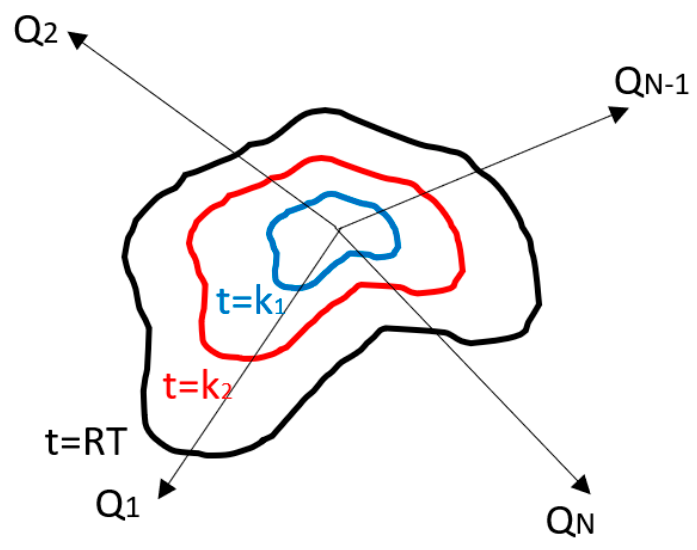
Figure 3. Contour lines of the functionality Q N.